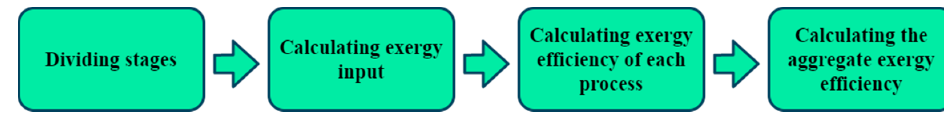
Figure 2. General steps of the Societal Exergy Analysis.